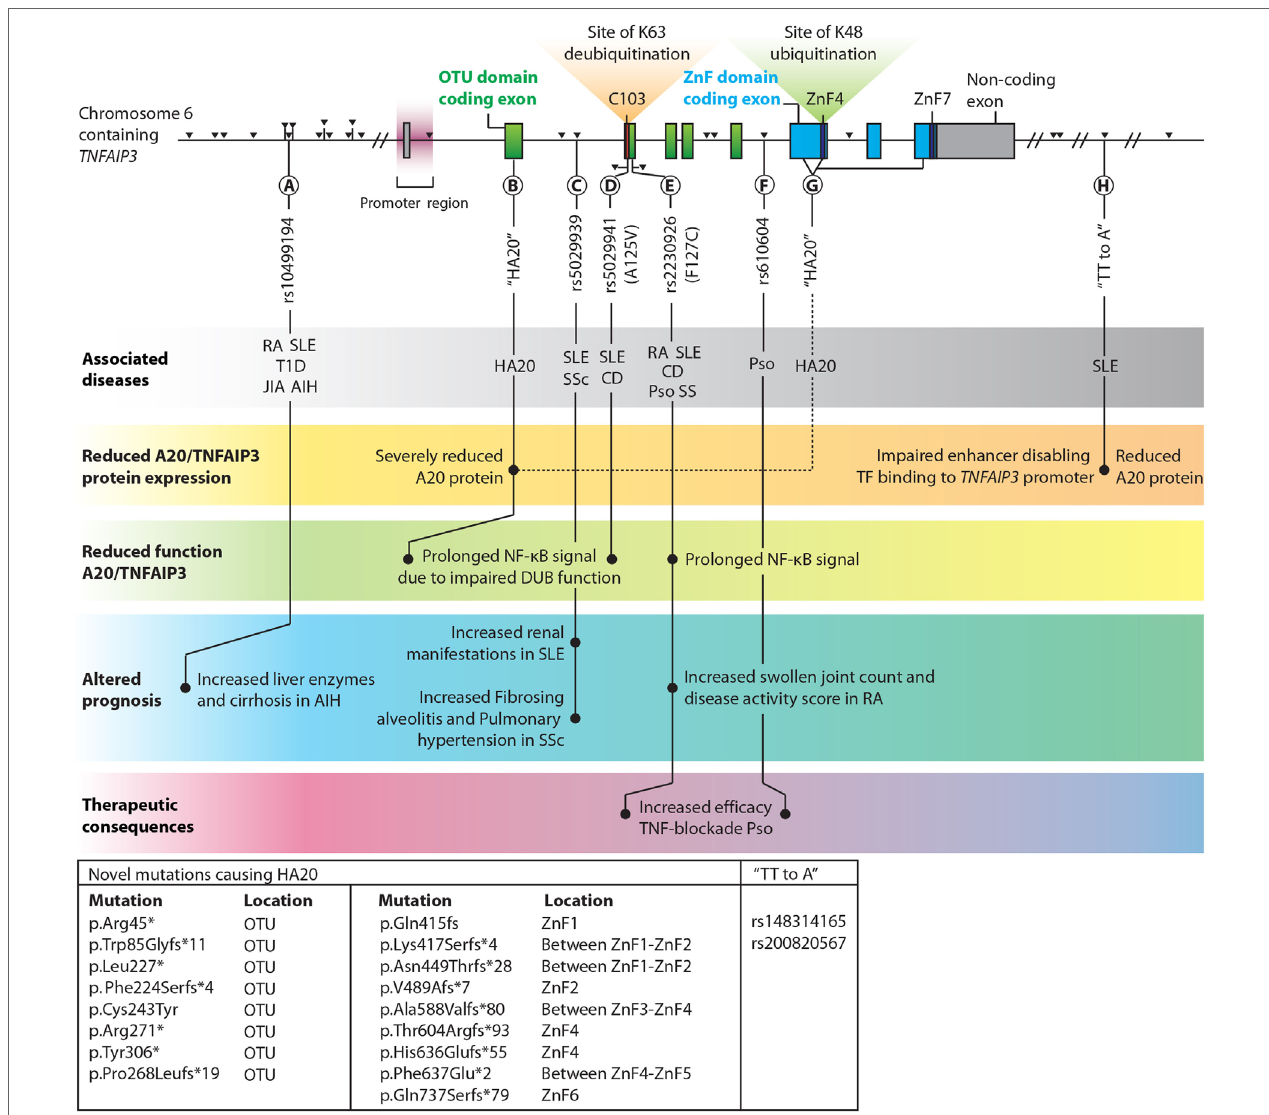
FiGURe 2 | Overview of single nucleotide polymorphisms (SNPs) and novel haplo-insufficiency of A20 (HA20) mutations in the proximity of TNFAIP3 which are highlighted in this review. TNFAIP3 gene SNPs, adapted with permission from: Springer Nature, Nature Reviews Immunology, A. Ma & B.A. Malynn © 2012 (7). Exons contributing to the OTU domain are depicted in green, and exons forming the zinc finger (ZnF) domains are blue. Non-coding exons are gray. The catalytic C103 site, ZnF4, and ZnF7 are highlighted. Black triangles indicate all known SNPs in the TNFAIP3 gene with associations with autoimmune diseases. Among the various documented SNPs/novel mutations, several lead to (1) reduced A20/TNFAIP3 protein level, (2) reduced A20/TNFAIP3 efficiency, (3) altered disease prognosis, or (4) therapeutic implications and are thus highlighted in this figure (A–H) . Known associations with (autoinflammatory and autoimmune) diseases for SNPs are indicated in the top gray bar. Multiple novel mutations causing “HA20” and two SNPs termed “TT > A” (associated with SLE) are listed in the box in the lower left corner. The reported p.Gln415fs mutation (113) should be reported as p.Lys417Serfs*4 to stay consistent with Human Genome Variation Society nomenclature (114). Abbreviations: OTU, ovarian tumor; ZnF, zinc finger; TF, transcription factors; TNFAIP3, tumor necrosis factor α -induced protein 3; HA20, haploinsufficiency of A20; AIH, autoimmune hepatitis; SLE, systemic lupus erythematosus; SSc, systemic sclerosis; RA, rheumatoid arthritis; T1D, type 1 Diabetes; JIA, juvenile idiopathic arthritis; CD, Crohn’s disease; Pso, psoriasis; SS, Sjögren